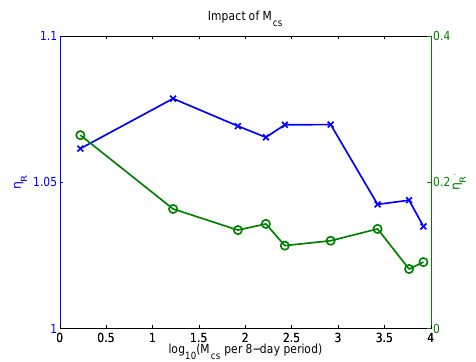
Figure 7. The impact of the number of compressive samples M cs on the reconstruction of F R ( η R ) and F R (cid:48) ( η R (cid:48) ). η R and η R (cid:48) are plotted on the Y1 and Y2 axes, respectively. Results are plotted for the 31st 8-day period. We see that M cs > 10 3 does not result in an appreciable increase in reconstruction quality. Also, M cs < 10 2 shows a marked degradation in η R (cid:48)